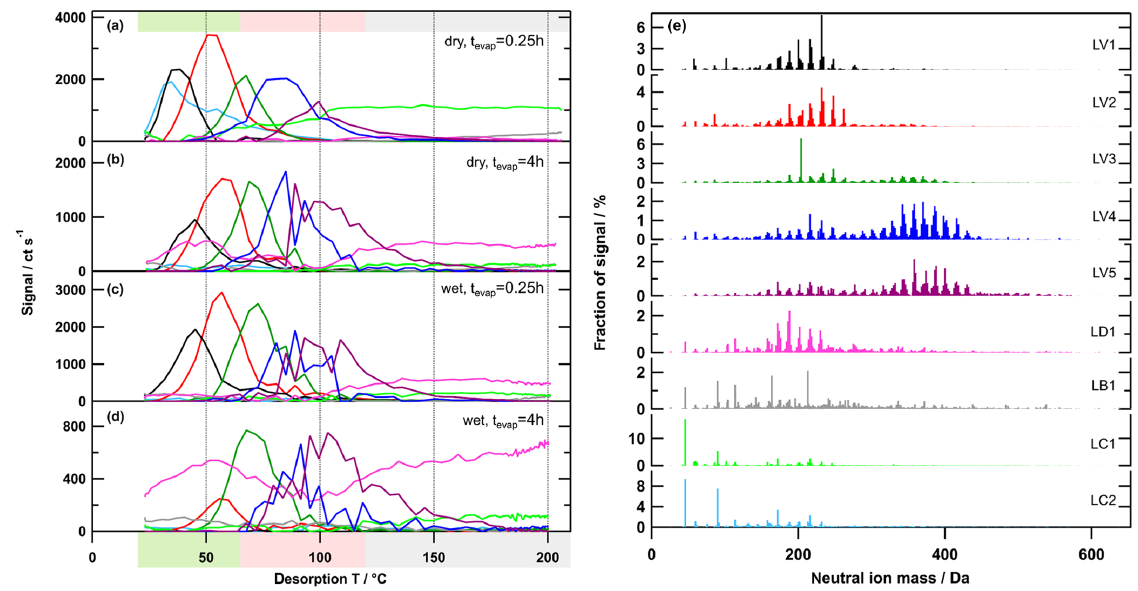
Figure 5. Factor thermograms (a–d) and factor mass spectra (e) for the 9-factor solution for the low-O : C case. Each factor mass spectrum is normalised. The colour code is the same for both panels. Background colours in the panel on the left indicate volatility classifications according to Donahue et al. (2006) and are derived from T max – C ∗ sat calibrations (green: semi-volatile organic compounds (SVOCs), red: low-volatility organic compounds (LVOCs), and grey: extremely low volatility organic compounds (ELVOCs)). Note the different scaling for the y axes in (a) – (d) .